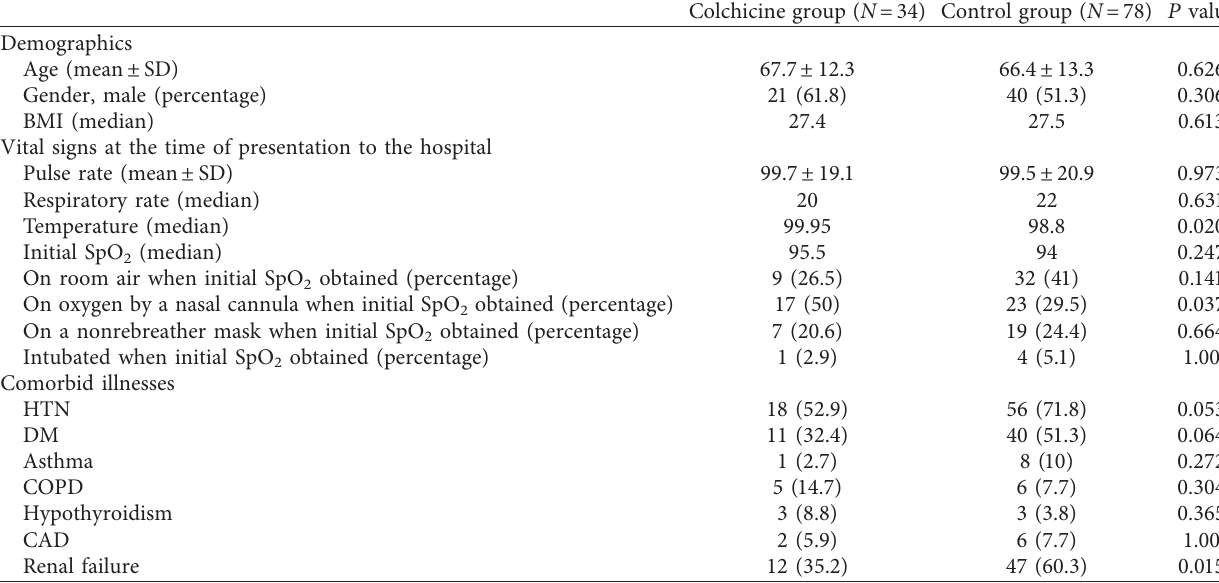
Table 2: Baseline characteristics, vital signs at the time of presentation to the hospital, and underlying comorbidities in comprehensive analysis colchicine and control groups (only including patients having at least two different timepoint measurements for at least two inflammatory markers (either D -dimer, CRP, LDH, or ferritin)). Age and pulse rate were normally distributed; the independent t -test was used to compare the two groups. BMI, temperature, oximetry (SpO 2 ), and respiratory rate were nonnormally distributed; the Man- n–Whitney U test was used to compare the two groups. The χ 2 test was used to compare the gender, patients on room air, oxygen by a nasal cannula, a nonrebreather mask, the prevalence of HTN, DM, and renal failure in the two groups. Fisher’s exact test was used to compare the number of patients intubated at the time of presentation, the prevalence of asthma, COPD, hypothyroidism, and CAD in the two groups.